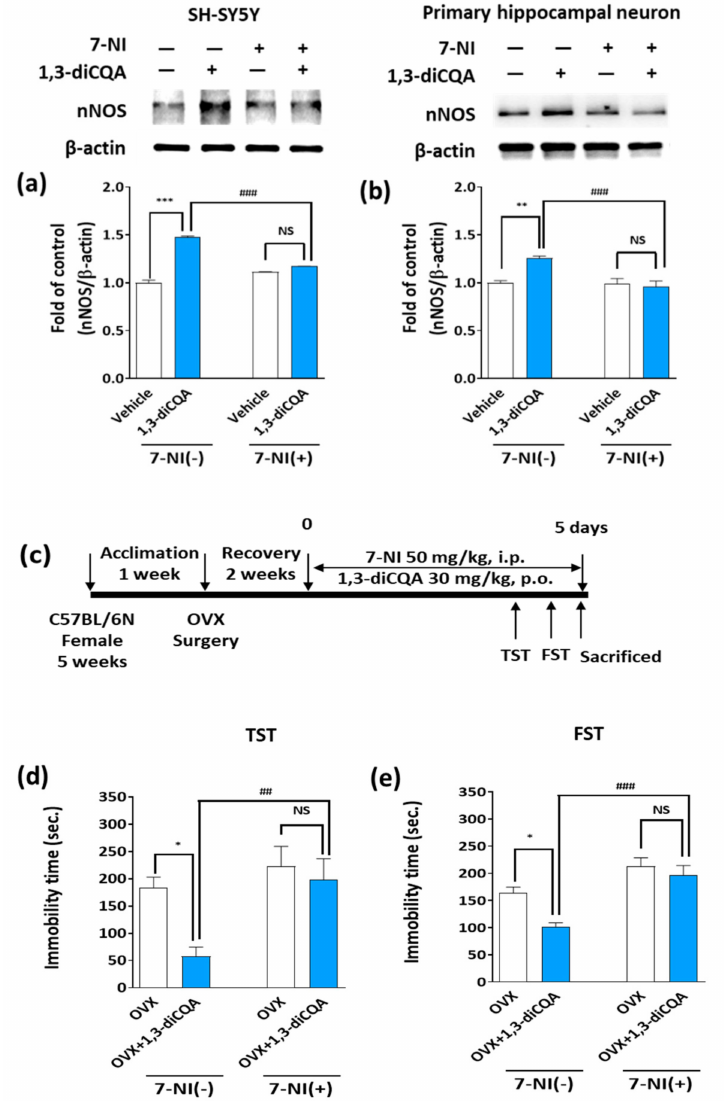
Figure 7. Effects of a specific nNOS inhibitor, 7-NI, on nNOS levels induced by 1,3-diCQA. SH-SY5Y human neuroblastoma cells and primary hippocampal neurons were incubated with 5 µ M 1,3-diCQA for 24 h in the presence or absence of 7-NI (200 µ M for 6 h). 1,3-diCQA induced nNOS level, whereas 7-NI inhibits this effect in the ( a ) SH-SY5Y cells and ( b ) primary hippocampal neurons. ( c ) Schematic illustration showing the experimental schedule. Anti-immobility effect of 1,3 diCQA is reversed by 7-NI co-treatment in ( d ) TST and ( e ) FST in OVX mice. Results are presented as mean ± SD. * p < 0.05, ** p < 0.01, *** p < 0.001 vs. OVX group; ## p < 0.01, ### p < 0.001 vs. OVX+1,3-diCQA group, NS; not